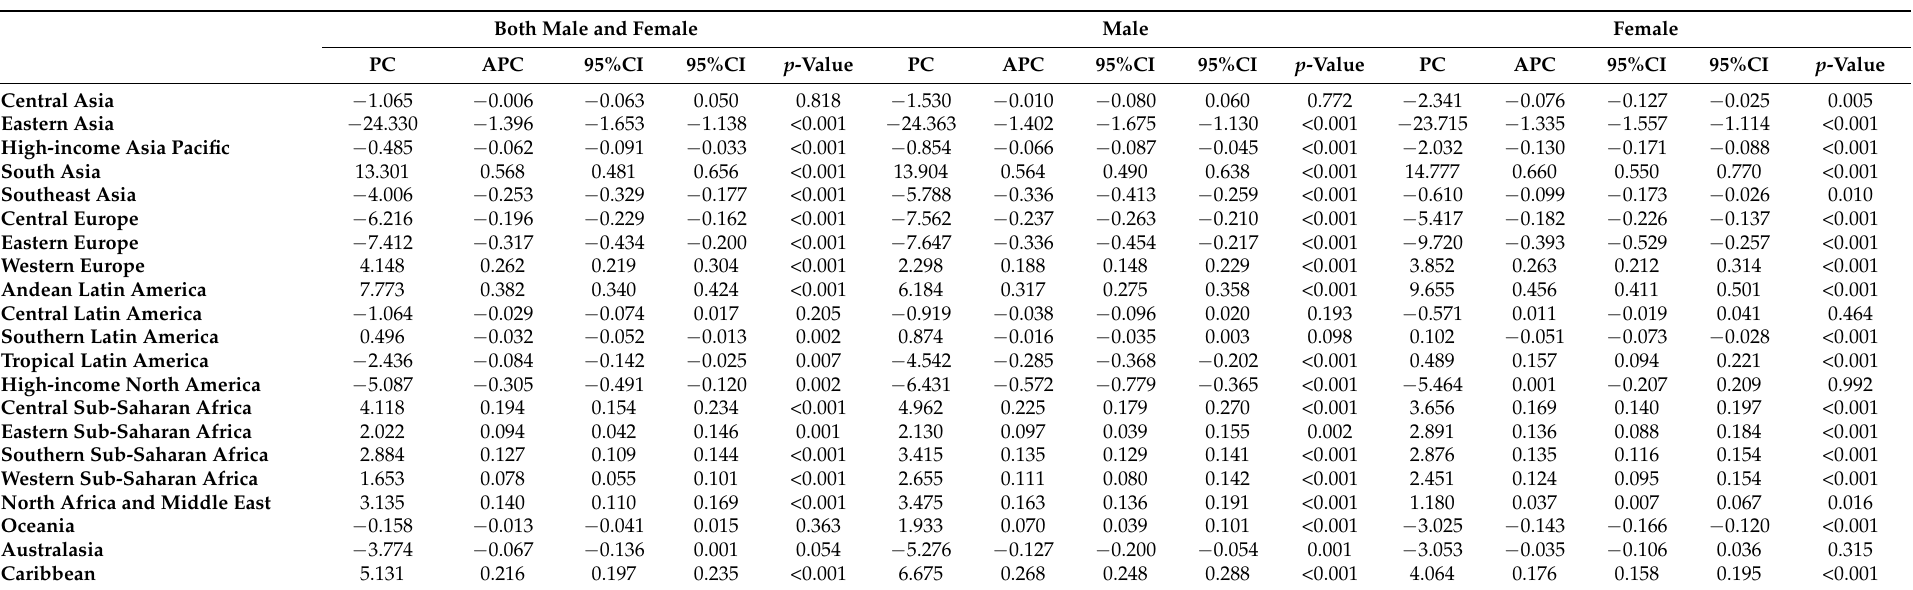
Table 2. Percentage change and annual percentage change of age standardized incidence rate of urolithiasis stratified by gender and 21 regions.